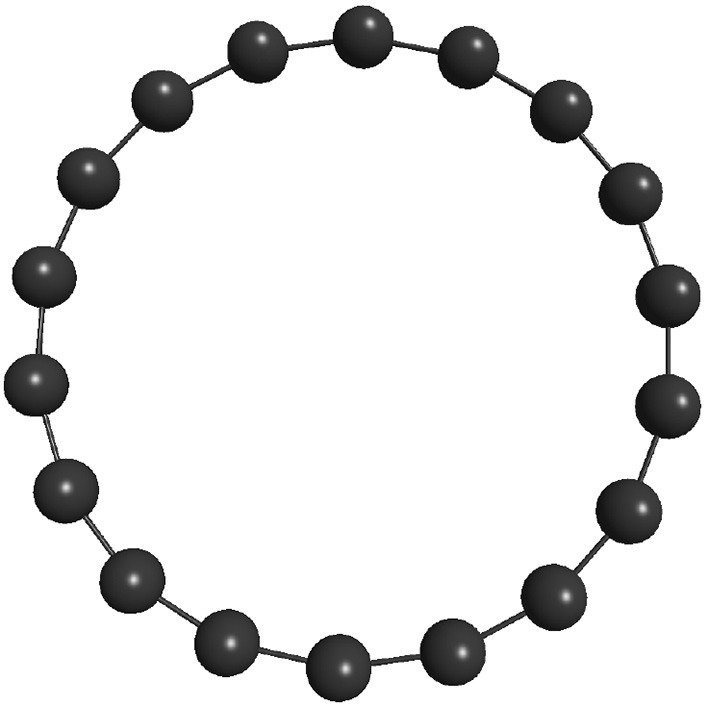
Most stable structure for C18 cluster: a planar single-ring (Kosimov et al., 2010).